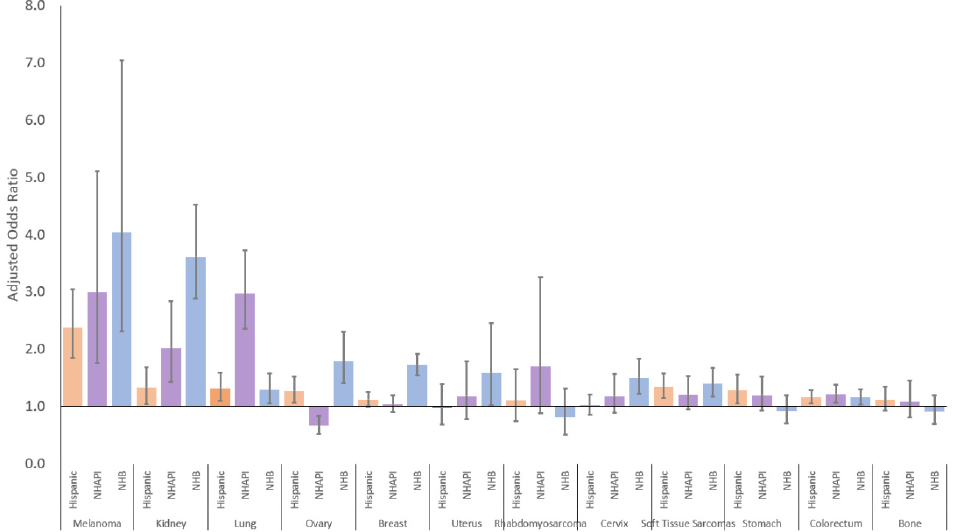
Figure 5. Risk of metastatic disease for racial/ethnic minority AYAs by cancer site. Reference group: non-Hispanic Whites.